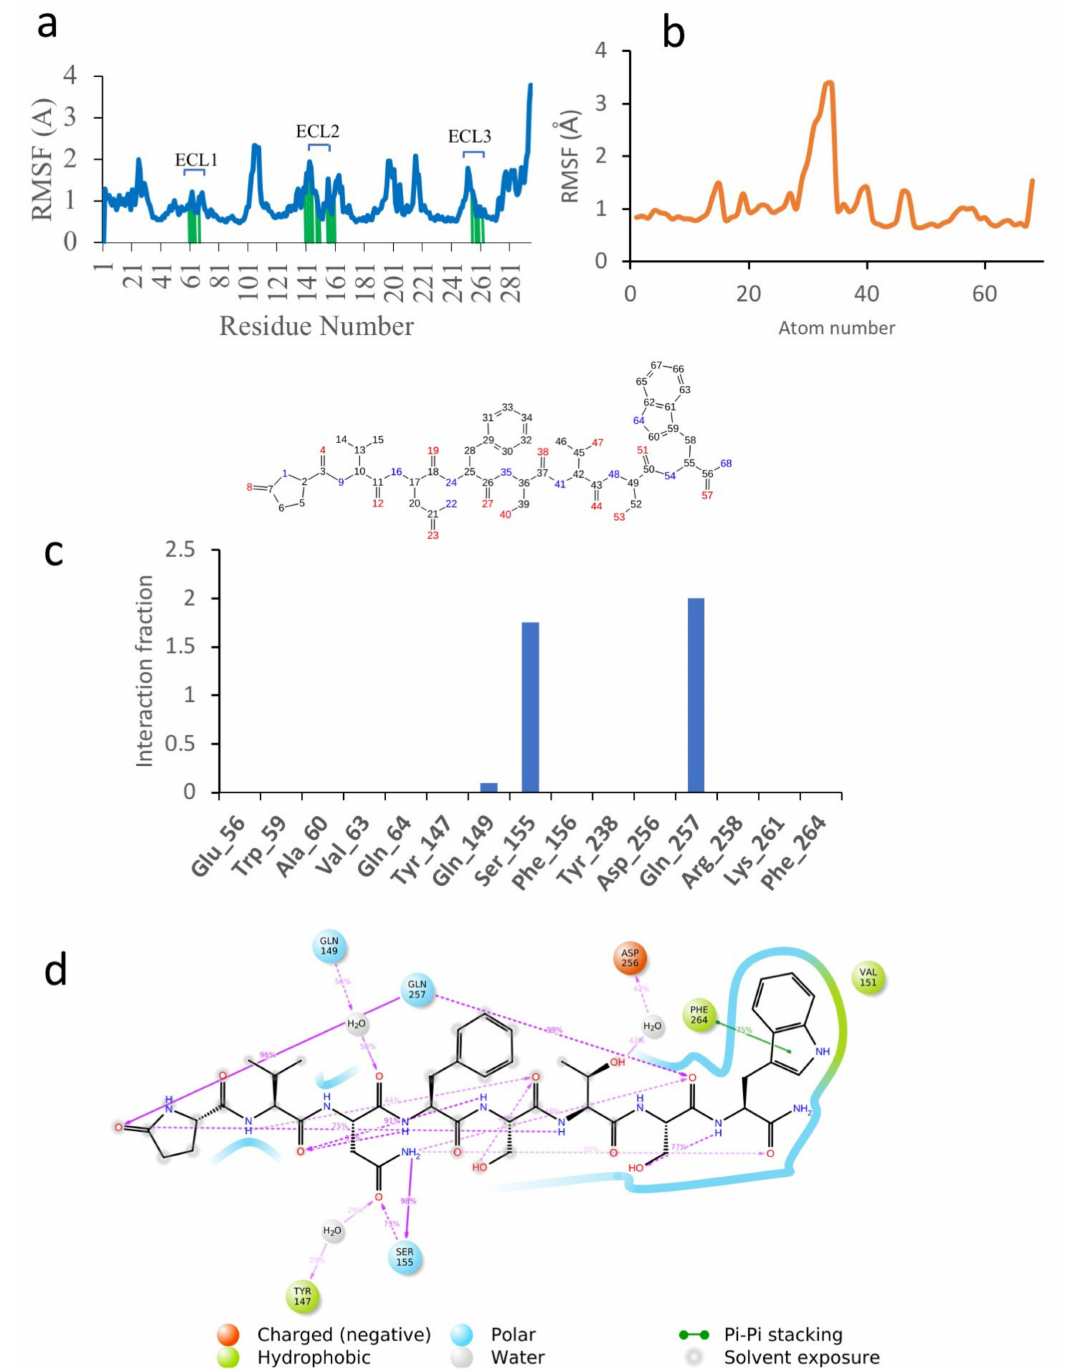
Figure 4. A 50 ns simulation of Dappu-RPCH bound to Dappu-RPCH R in a POPC membrane. ( a ) RMSF of receptor. Protein residues that interact with the ligand are marked with green-colored vertical bars. ( b ) RMSF of ligand. Atom numbers are shown in the schematic view below. ( c ) Receptor/ligand contacts during the simulation. The stacked bar charts are normalized over the course of the trajectory. ( d ) Details of ligand atom interactions with the protein residues. Interactions that occur for more than 30.0% of the simulation time in the selected trajectory are shown. Residues are represented as colored spheres, labelled with the residue name and residue number, and colored according to their properties. The ligand is displayed as a 2D structure. Interactions between the residues and the ligand are drawn as lines, colored by interaction type. The binding pocket is indicated by a line drawn around the ligand, colored by the color of the nearest residue. Solvent exposure is indicated on the ligand atoms, and by the break in the line drawn around the